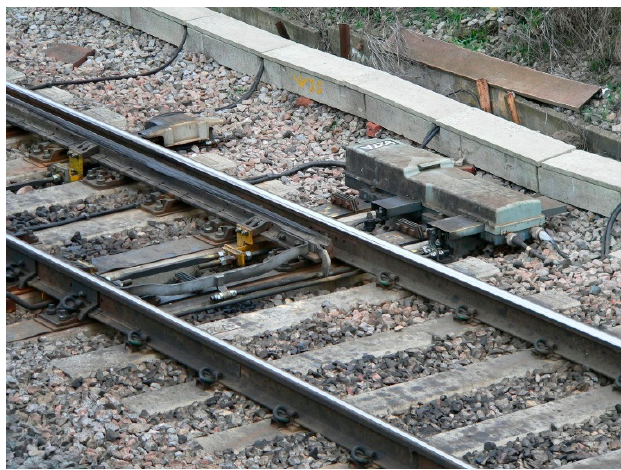
Figure 1. Point-operating machine (POM) (https://en.wikipedia.org/wiki/Railroad_switch).